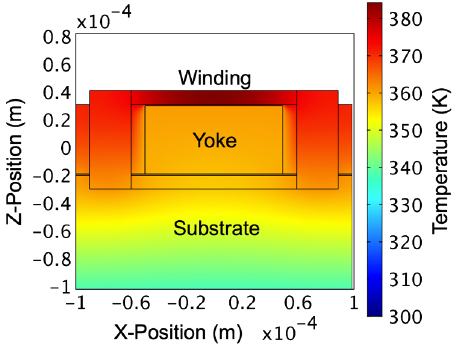
wafer.FIG. 16. Temperature distribution simulation (Kelvin) of a ¼ 400 (cid:1) m undulator winding cross section driven with (cid:2) u 5 A, producing 1.2 T, fabricated on a 200 (cid:1) m thick Si